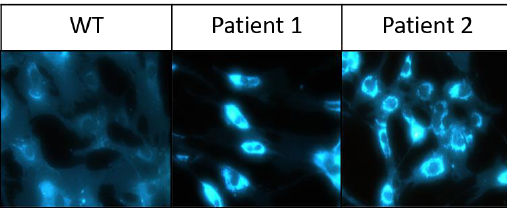
Figure 3. Filipin staining revealed lysosomal cholesterol accumulation in fibroblasts isolated from both NPC patients as compared to the healthy donor (WT). Patient 1: NPC-I1061T/P887L, Patient 2: NPC-D874V/D948Y.